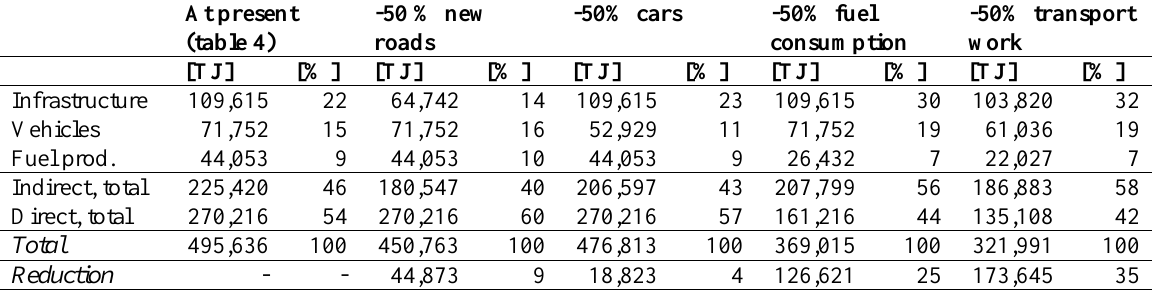
Table 5. Present situation and scenario 1-4 of annual energy associated with Swedish road